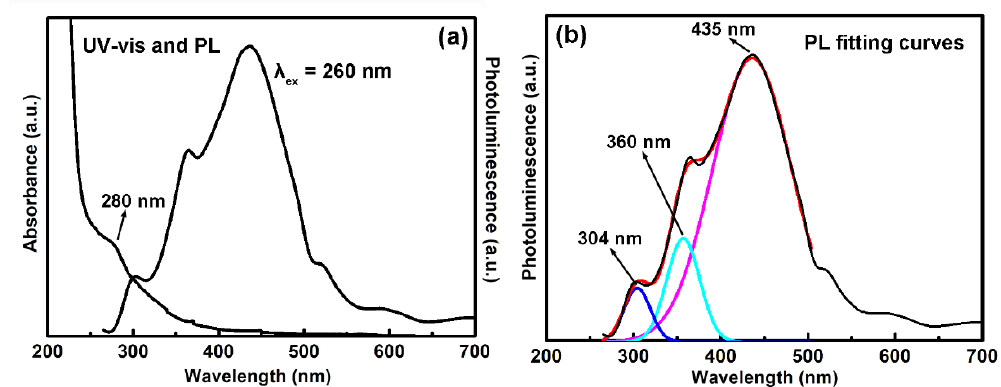
Figure 4. ( a ) UV-vis and photoluminescence (PL) spectra of the CNDs. ( b ) Fitting curves of the PL spectrum of the CNDs.